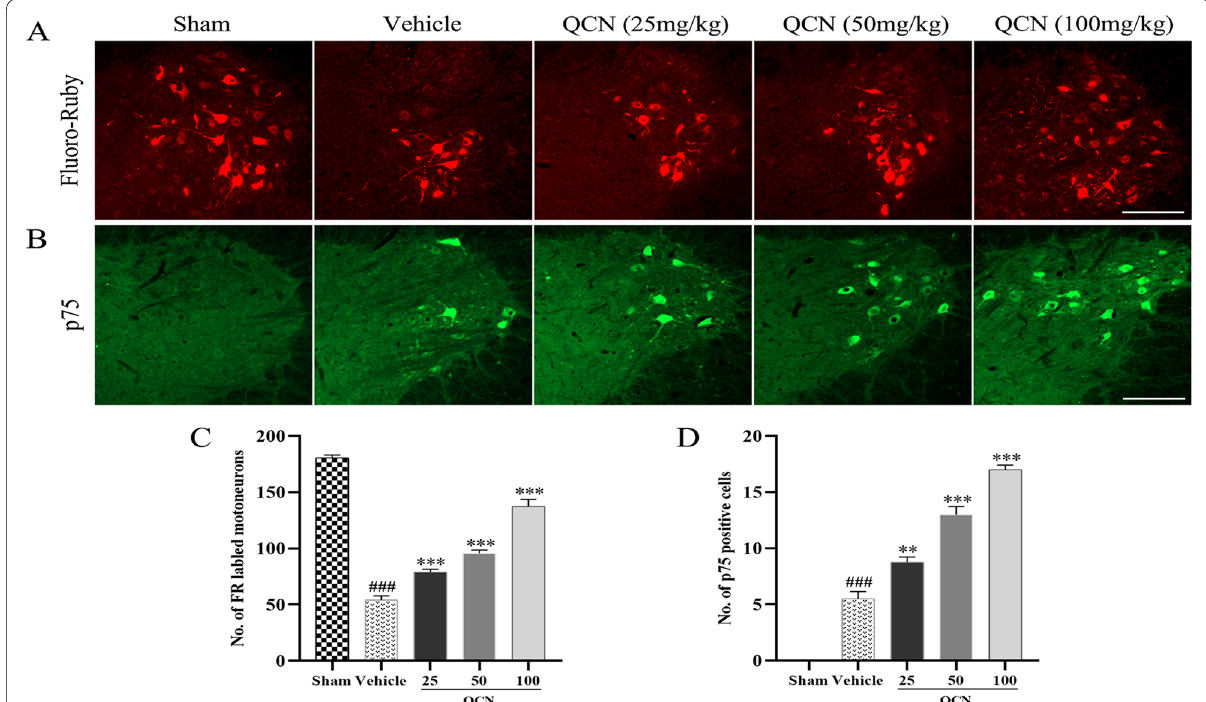
Fig. 2 Effects of QCN on the regeneration of motoneurons of BPA rats at week 8 post‑avulsion. Representative images of A Fluoro‑Ruby (FR) labeled motoneurons, and B P75‑positive motoneurons in the ipsilateral C6–7 ventral spinal segments. Quantification of C FG‑labeled cells and D P75‑immunoreactive (IR) cells of each group at 8 weeks. Data are expressed as the mean and *** p < 0.001 vs the vehicle group. Scale bar 200